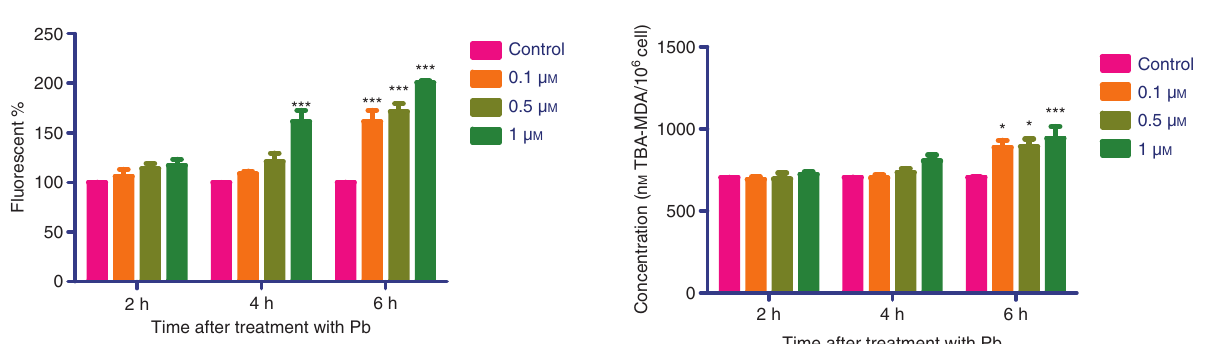
Figure 4: Induction of lipid peroxidation after treatment of lympho- cytes with Pb acetate.